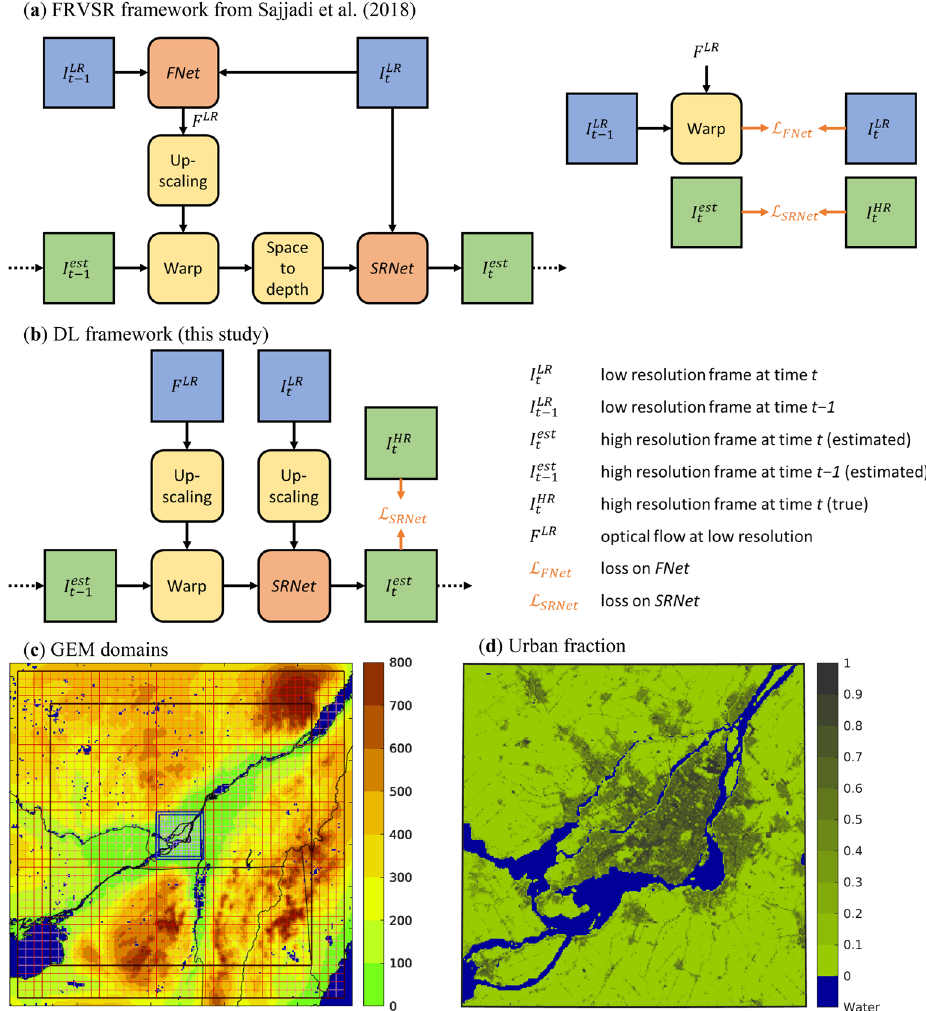
Fig. 1 a The architecture of the FRVSR framework by Sajjadi et al. (2018). Blue boxes are used for LR input data, yellow boxes for field operators, green boxes for HR data and red boxes for CNNs. Loss terms are shown in orange. b Proposed deep learning framework for precipitation. c GEM computational domain at 2.5 km (brown; every 5th grid cell shown) and 250 m (blue; every 20th grid cell shown). The outer thick lines represent the model domain, while the inner thick lines represent the model free domain. Background colors represent orography (m asl). d Urban fraction in the 250 m domain. Water bodies are shown in dark